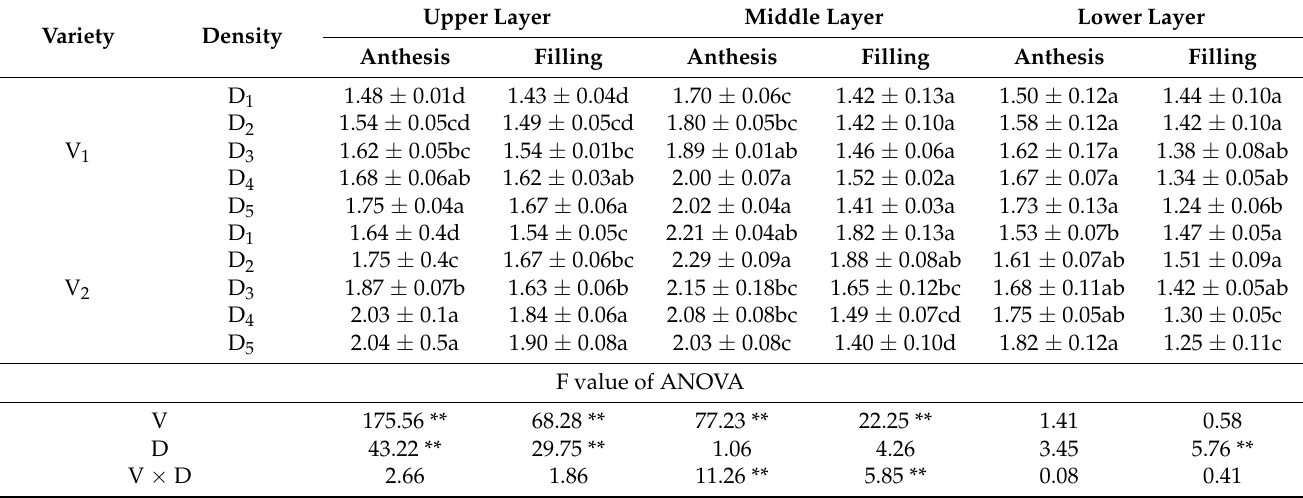
Figure 4. Effects of planting density on leaf area index (LAI) of winter wheat for the Xindong 50 (V 1 ) and Sangtamu 4 (V 2 ) varieties, as recorded at the following stages: before overwintering stage (BS), jointing stage (JS), heading stage (HS), anthesis stage (AS), filling stage (FS), and mature stage (MS). Table 1. Effects of planting density on the leaf area index (LAI) of uniformly sown winter wheat (mean ±